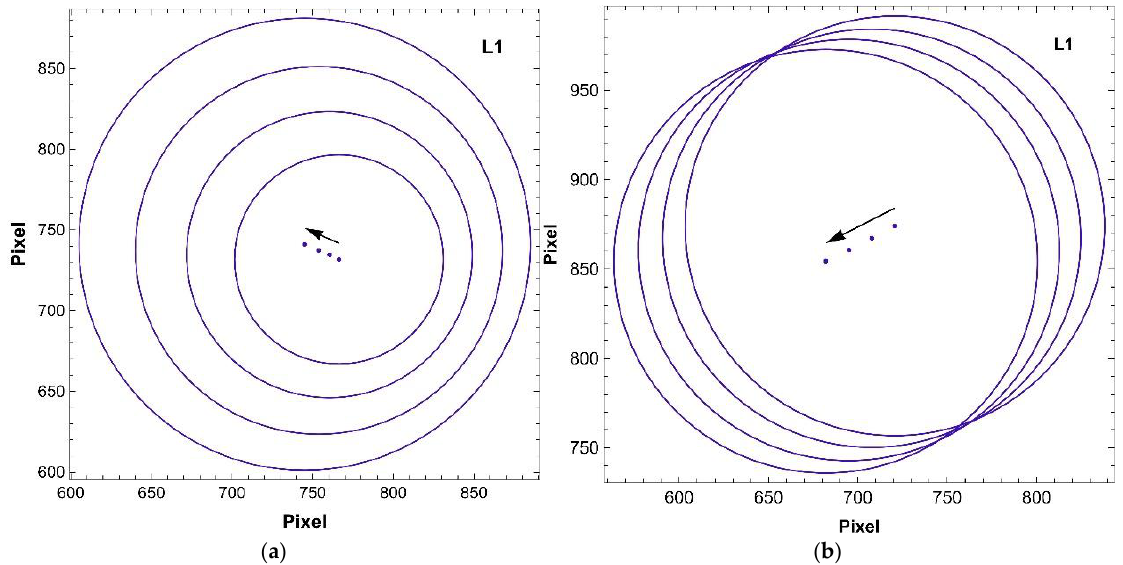
Figure 6. L1 (413 nm) LED illumination spot changes represented by the position of the centre of illumination spot (dots) and the size of the beam diameter at FWHM (circles) tested for four different distances between the fan-out (1) and screen (2) (Figure 5) ( a ) without the collimator and ( b ) with the collimator. Black arrows point out the translation direction of the illumination spots when the distance increased.